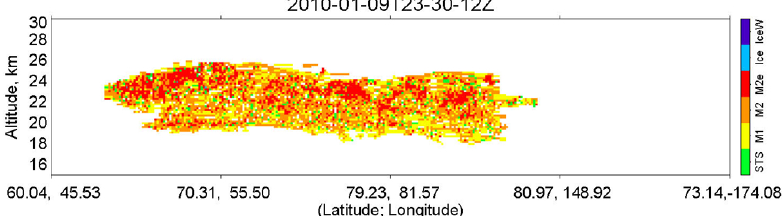
Fig. 4. Example of noise-induced misclassification in a CALIOP PSC scene from an orbit on 9 January 2010. PSC composition class is indicated by color scale at